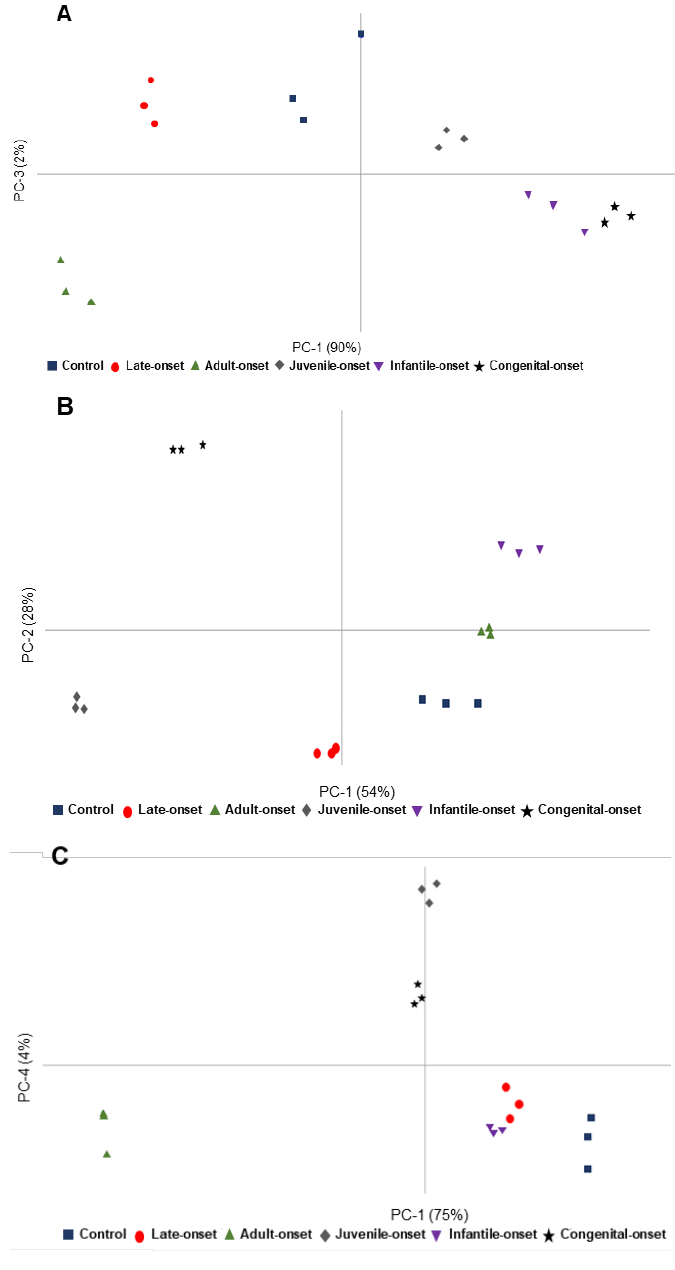
Figure 5. PCA scores profile of DM1-derived fibroblasts and control. ( A ) 3000–2800 cm −1 region. ( B ) 1800–1500 cm −1 region. ( C ) 1200–900 cm −1 region. ( B ) 1800–1500 cm − 1 region. ( C ) 1200–900 cm − 1